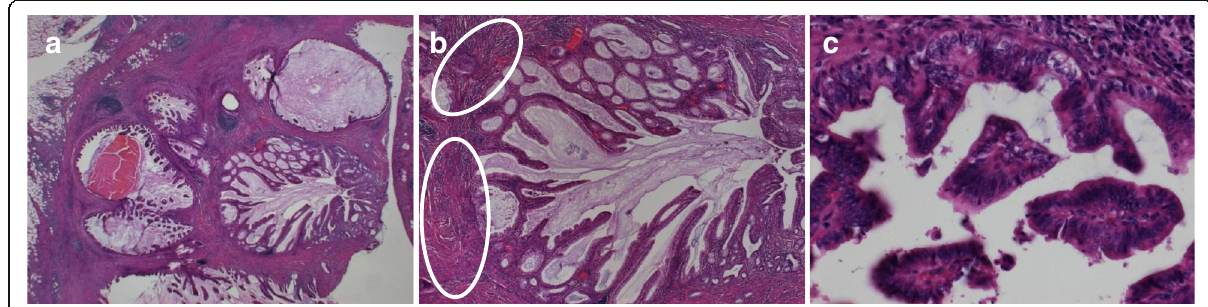
Fig. 3 Histopathological findings. a Papillary tumors with cyst formation which presented mucin secretion were detected, and the Rokitansky- Aschoff sinus was formed (hematoxylin-eosin staining, × 40). b The smooth muscle became hyperplastic in the stromal tissue surrounding the papillary tumors (circle) (hematoxylin-eosin staining, × 100). b Epithelial cells. The nucleus chromatin increased, the karyotype was irregular, and the nuclear body became clear, showing low-grade dysplasia. (Hematoxylin-eosin staining, × 400)